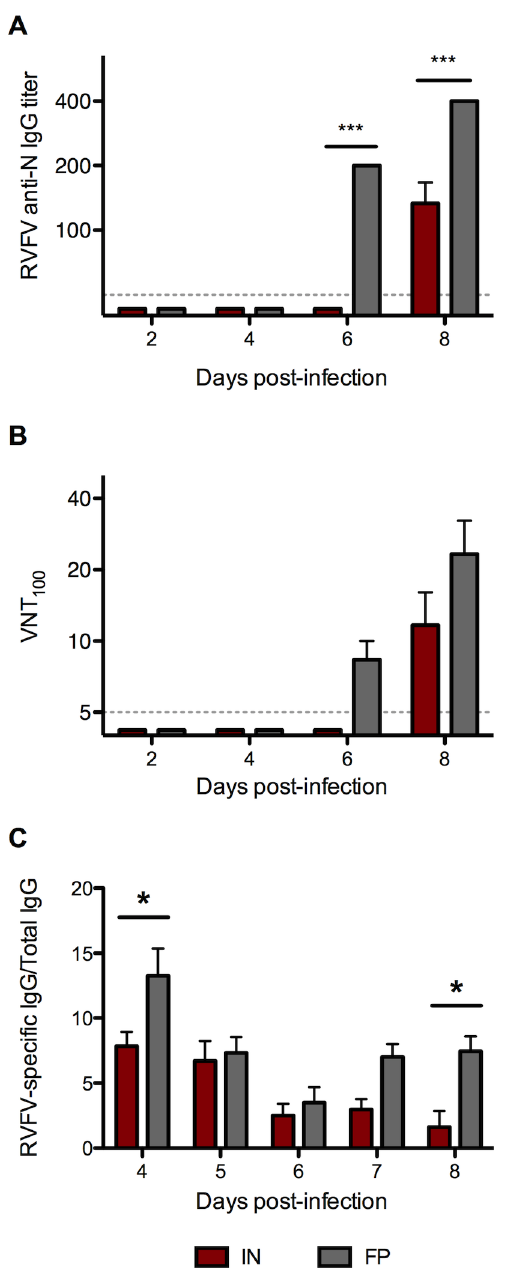
Figure 4. FP-inoculated mice had a significantly stronger humoral response following D NSs virus infection than IN- inoculated mice. Serum samples were assayed for (A) RVFV anti-N IgG antibody titers and (B) RVFV neutralizing antibody titers (averages based on 3 mice per group). Splenocytes were analyzed for (C) RVFV- specific B cells as determined by ELISPOT (averages based on 5 mice per group).